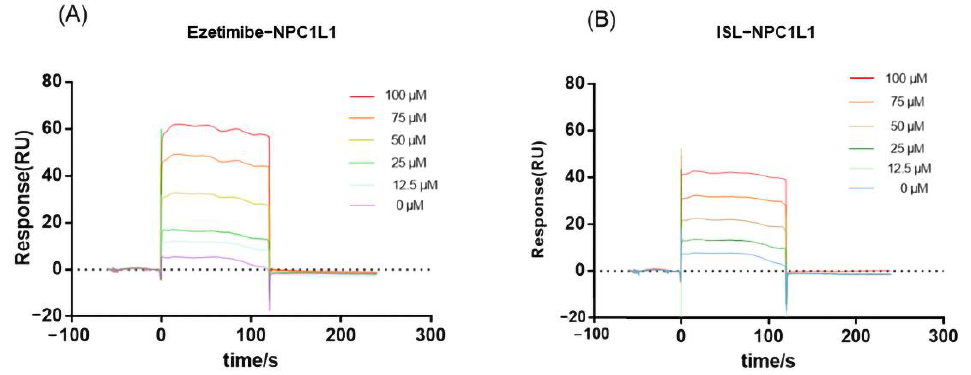
Figure 2. SPR assay of the interaction of ISL with NPC1L1. ( A ) Binding sensing map showing the interaction of EZ with immobilized NPC1L1. ( B ) Binding sensing map showing the interaction of ISL with immobilized NPC1L1. (Inhibitor concentrations were 0, 12.5, 25, 50, 75 and 100 μM ).